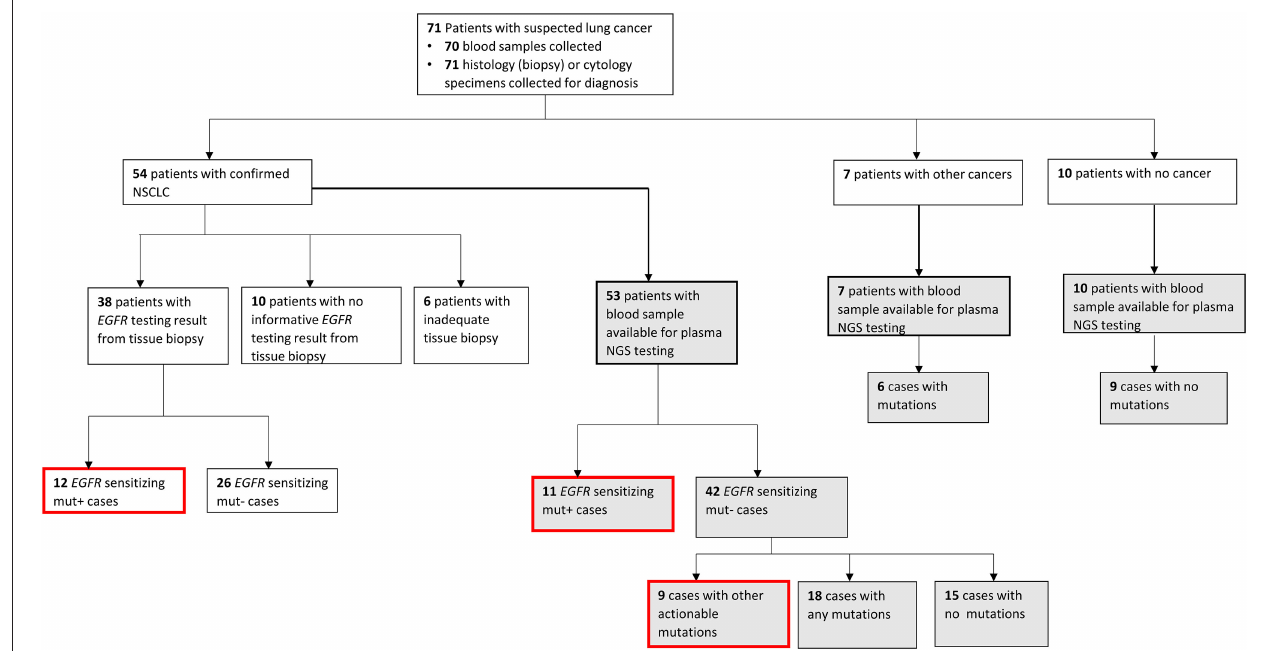
FIGURE 1 | Patient enrollment and testing workflow. Flowchart showing the patient enrolment, diagnosis, sample availability, type of testing conducted, and mutation findings. Gray-filled boxes indicate testing results from plasma next-generation sequencing (NGS) and red-outlined boxes are all clinically actionable findings made in this study for non-small cell lung carcinoma (NSCLC) cases.